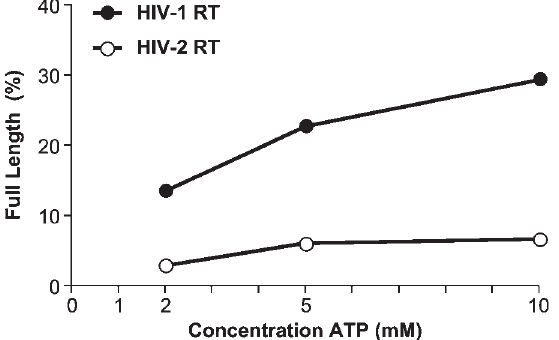
Figure 3. Excision/Extension of AZTMP by HIV-1 RT and HIV-2 RT As described in Materials and Methods, a 5 9 end-labeled primer was annealed to a template. The 3 9 end of the primer was blocked by the addition of AZTMP. (A) The excision/extension assays were performed with AZTMP-blocked primers in the presence of high levels of dNTPs (100.0 l M each), which favors formation of the ternary complex (RT/DNA/dNTP) and the indicated concentrations of NaPPi (50.0, 100.0, 200.0 l M). All experiments were done at least in duplicate; a typical result is shown. (B) Excision/extension of an AZTMP-blocked primer using high levels of dNTPs (100.0 l M each dNTP) and the indicated concentrations of ATP (2.0, 5.0, 10.0 mM). All experiments were done at least in duplicate; a typical result is